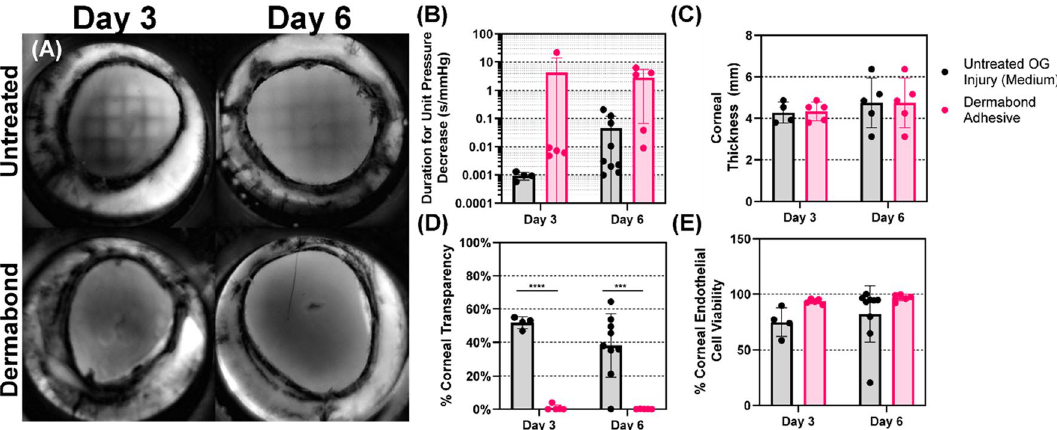
Figure 9. Assessment of Dermabond adhesive on open globe injuries. ( A ) Representative transparency images of medium OG injured (top row) and Dermabond treated (bottom row) eyes at D3 (left column) and D6 (right column). ( B ) Outflow duration ( C ) corneal thickness, ( D ) corneal transparency and ( E ) cell viability for untreated and Dermabond treated tissue immediately post injury (D3 organ culture) and 72 h post injury (D6 organ culture). Results are shown as mean and error bars denote standard deviation throughout. Asterisks denote (*) p < 0.05, (**) p < 0.01, (***) p < 0.001, and (****) p < 0.0001 as determined by two-way ANOVA, post- hoc Šídák